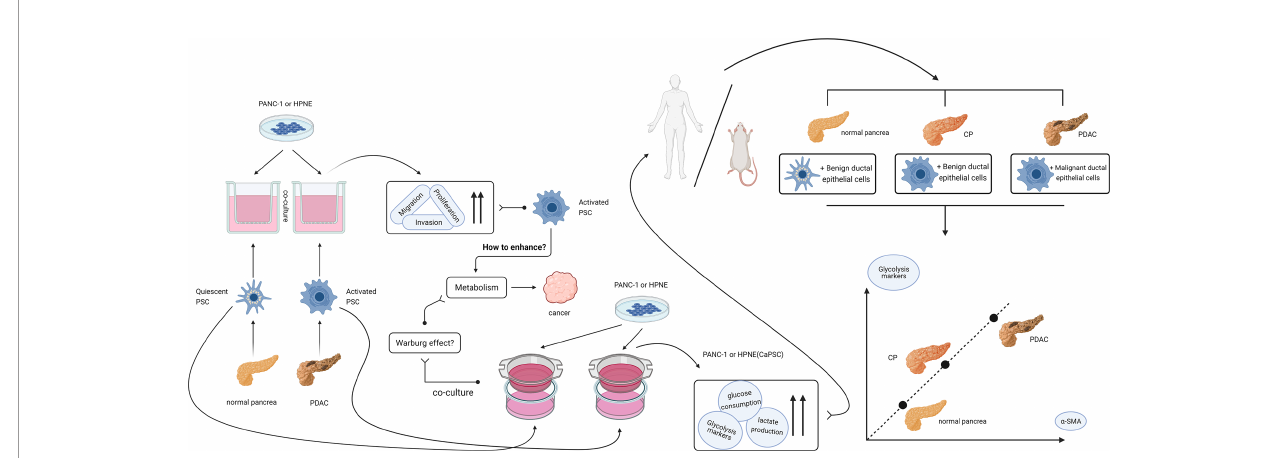
FIGURE 7 | Design idea and veri fi cation fl ow chart of this study. After fi nding that activated PSCs of pancreatic cancer origin can promote the proliferation, migration and invasion of benign and malignant pancreatic duct epithelial cells, we hypothesized that activated PSCs may promote the malignant transformation of chronic pancreatitis. In the process of searching for the mechanism, a series of experiments con fi rmed that the activated PSCs could promote the Warburg effect in benign pancreatic duct epithelial cells in vitro , and the correlation between the glycolytic proteins of pancreatic duct cells and the activated PSCs in the peri-pancreatic duct matrix was con fi rmed in vivo